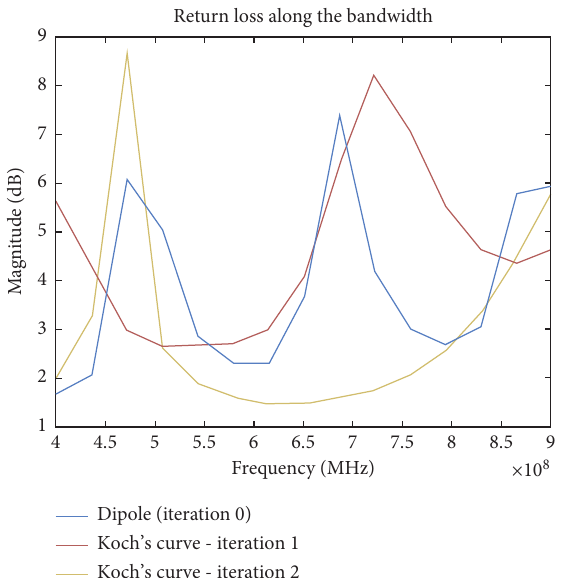
Figure 19: Return loss for dipole and Koch’s curve antennas.